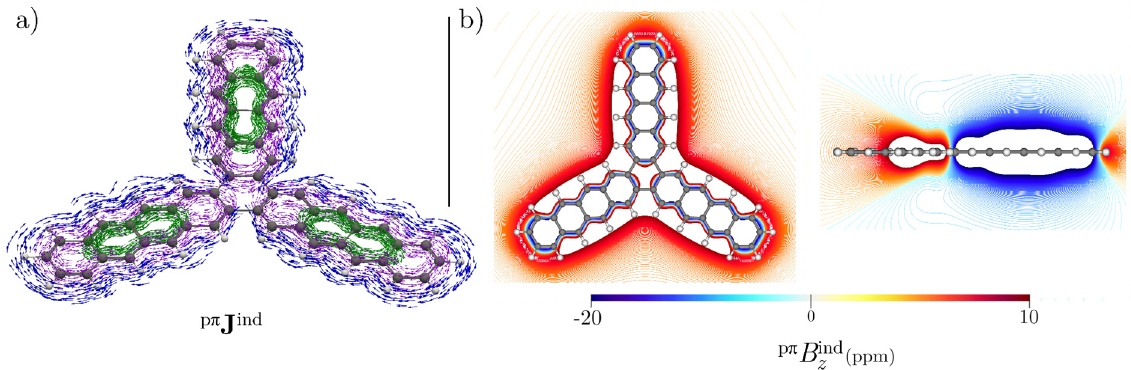
Figure 6. ( a ) p π J ind vector maps showing the diatropic peripheral ring current (in blue), tetracene-like ring currents (in